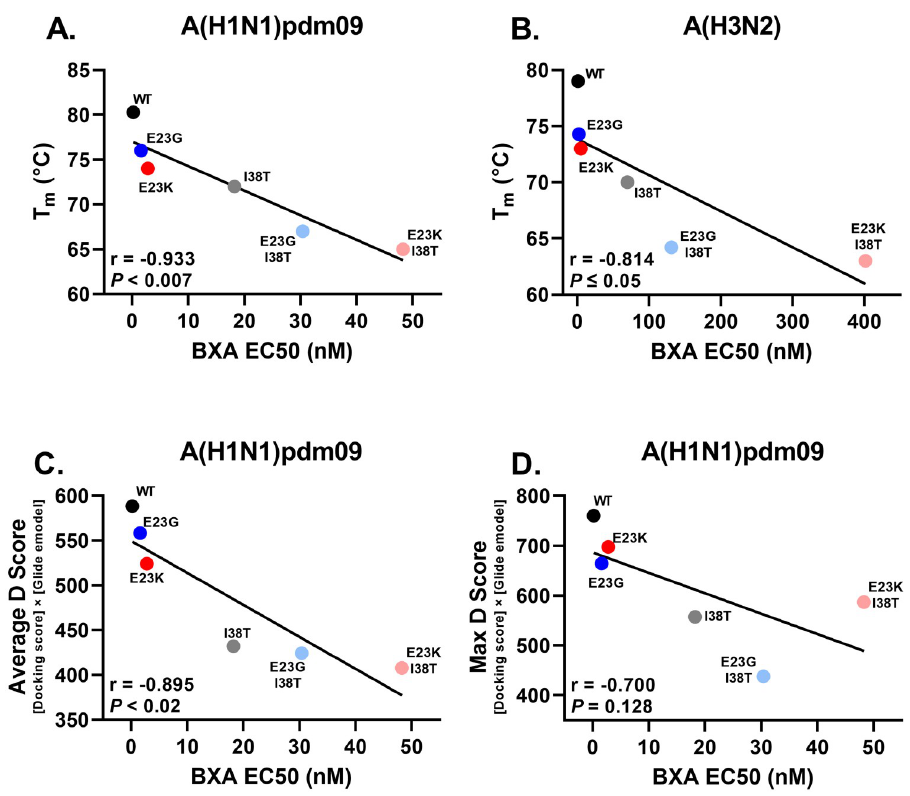
Fig 5. Correlation between the rPA N thermal stability or the molecular docking score and the BXA EC 50 . Pearson correlation analysis of A, B) rPA N -BXA thermal stable T m values vs. BXA EC 50 s, or C, D) in silico derived docking scores vs. BXA EC 50 s. The virus, docking mode, Pearson correlation coefficient, and statistical significance is listed in each panel.